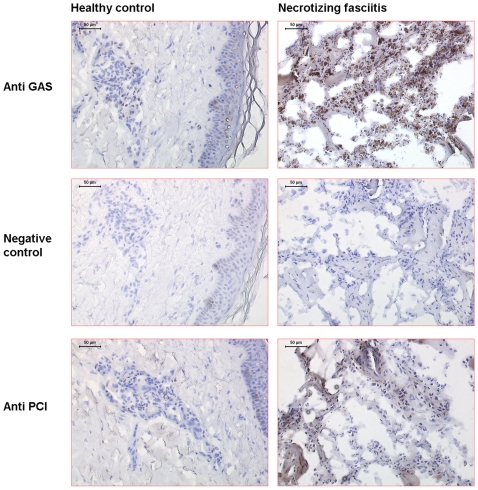
Immuno-histochemical analysis of tissue biopsies.Tissue biopsies were obtained at the epicenter of the infection from four patients with necrotizing fasciitis caused by Streptococcus pyogenes. For comparison, a skin biopsy was obtained from a healthy volunteer. The biopsies were sectioned and stained for Streptococcus pyogenes (GAS), PCI, and control staining where the primary antibody was omitted (ctrl). The figure shows 1 representative biopsy from a patient and the healthy control.